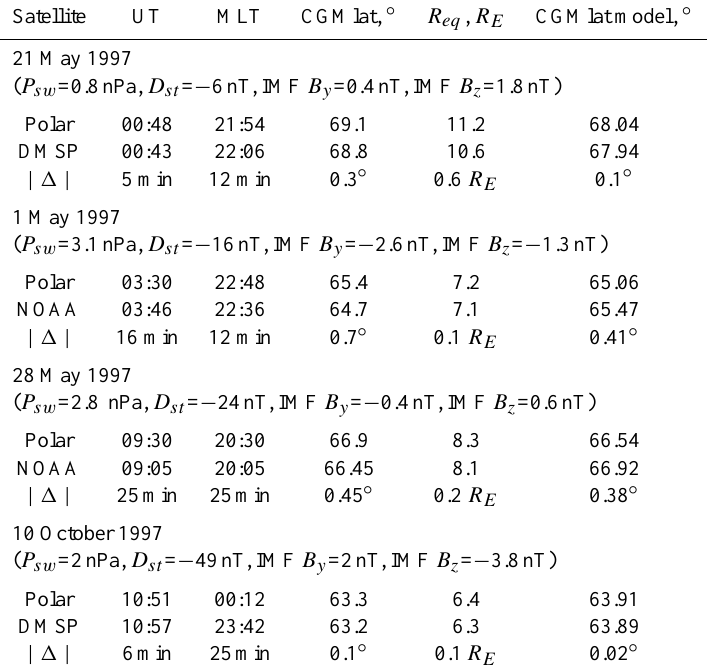
Table 1. Positions of Polar, NOAA and DMSP satellites for conjugate events, together with solar wind parameters, D st index, and corre- sponding magnetic field line